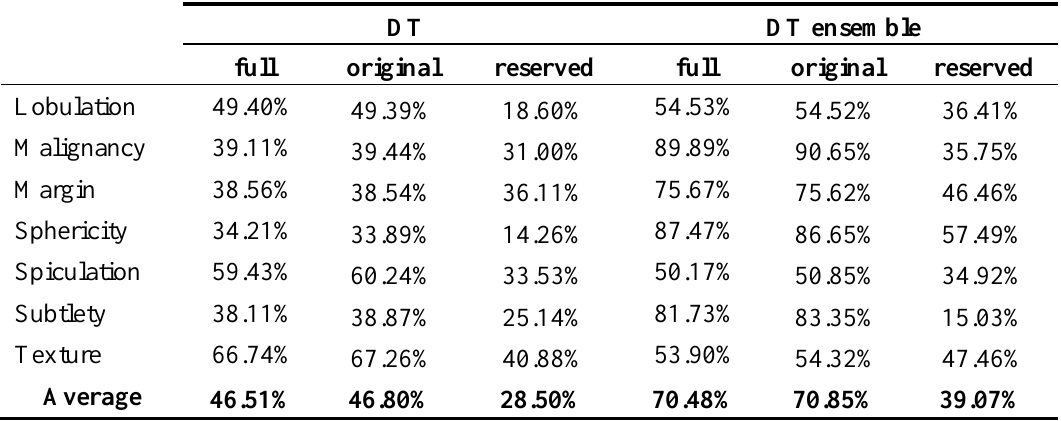
Table 10. Classification Accuracy of decision trees on full, original and reserved data sets (single classifier vs. ensemble of